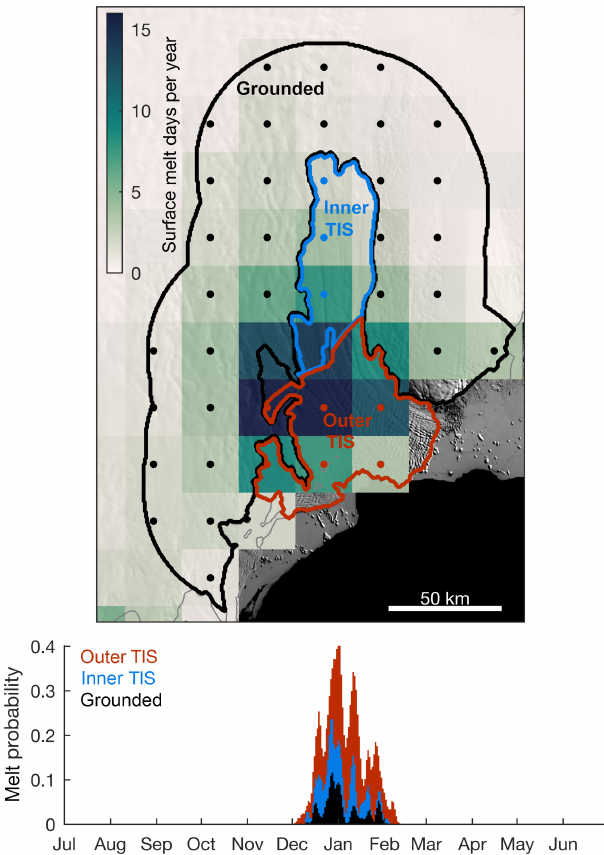
Figure 4. Surface melt observations, 2000–2017. Spatial distribu- tion of mean annual surface melt and daily probability of surface melt in each subdomain. Low-elevation areas near the coast expe- rience more days of surface melt than high-elevation grounded ice, but the timing of surface melt is similar throughout the domain. Data are from Picard and Fily